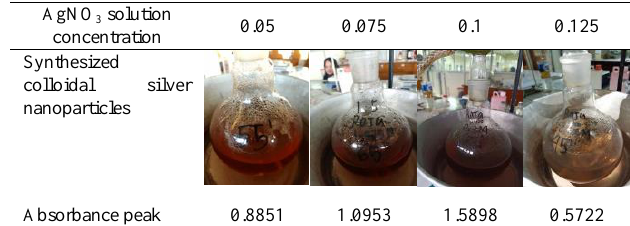
Table 1. UV Spectrometer peak absorbance of synthesized colloidal